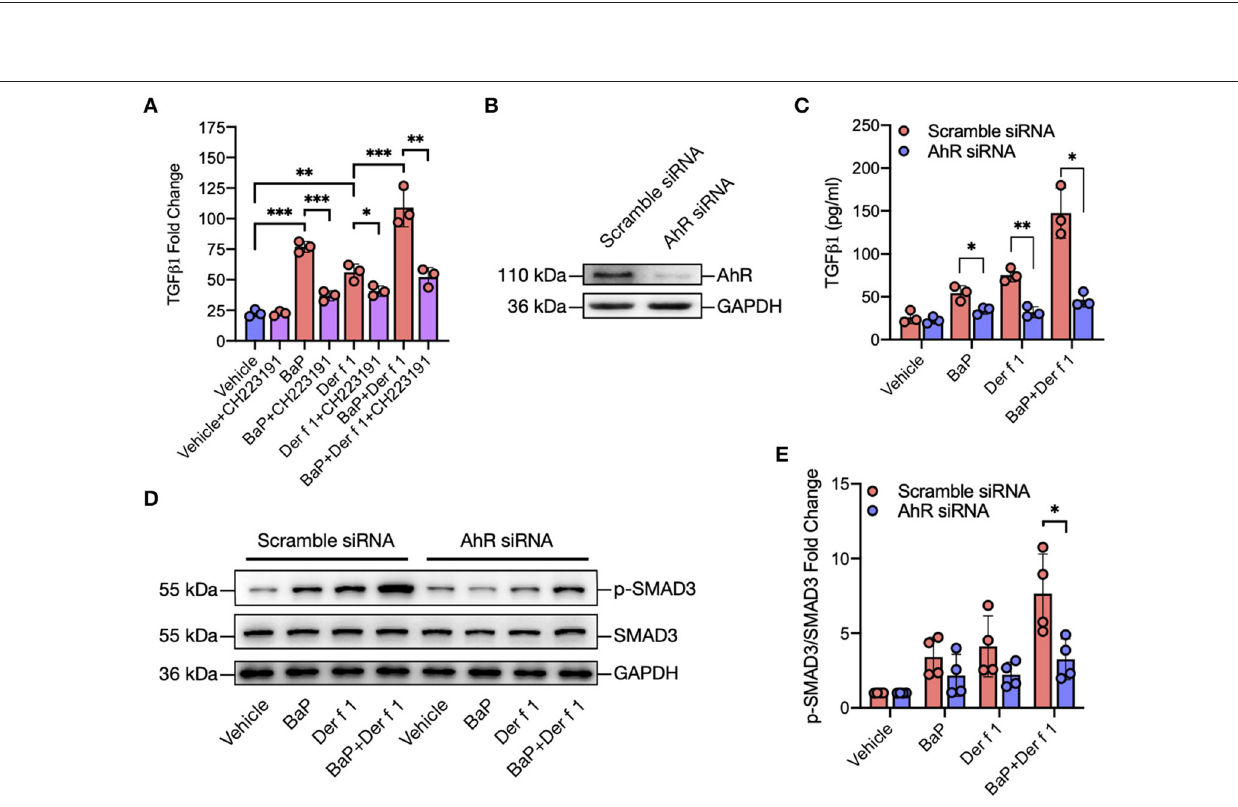
Frontiers in Immunology |